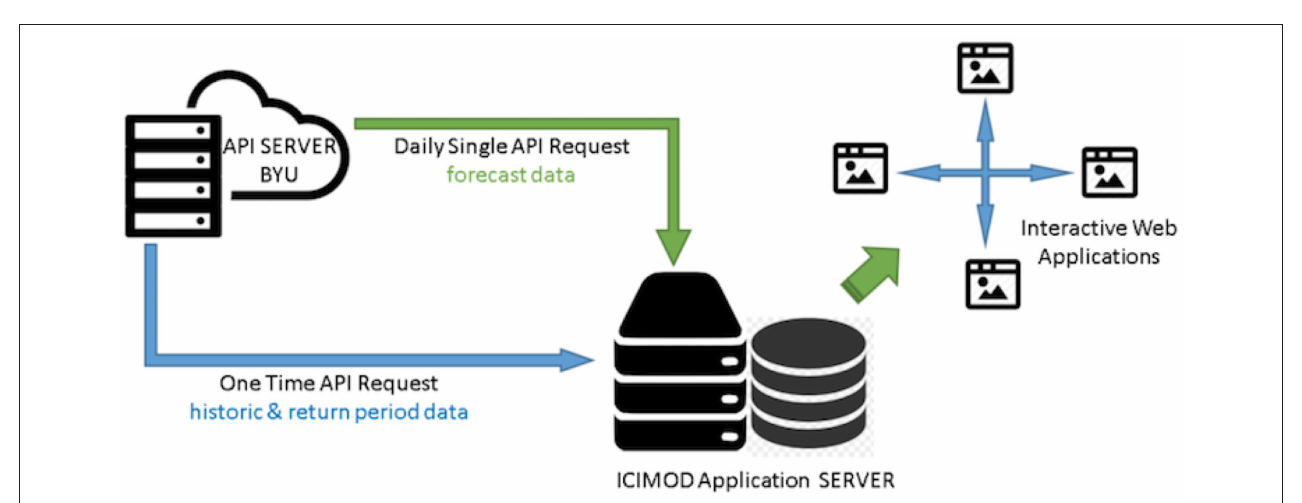
FIGURE 10 | ICIMOD